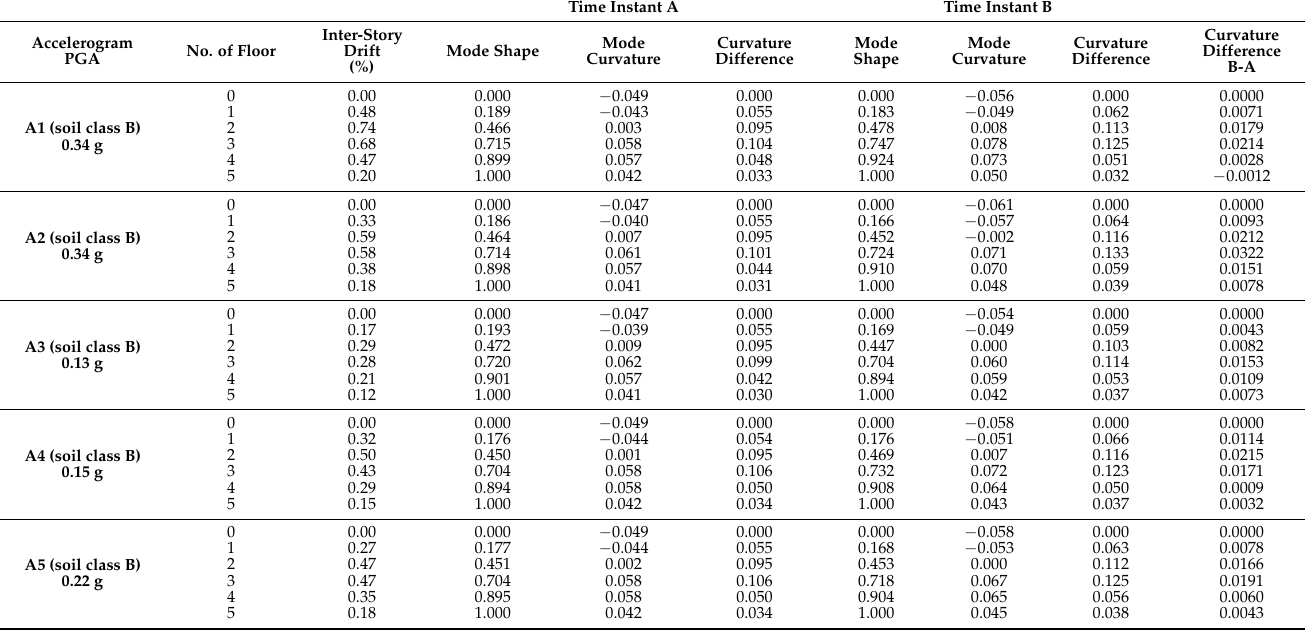
Table A2. Values of the main parameters evaluated for the 5-story numerical model in correspondence to the fundamental mode of